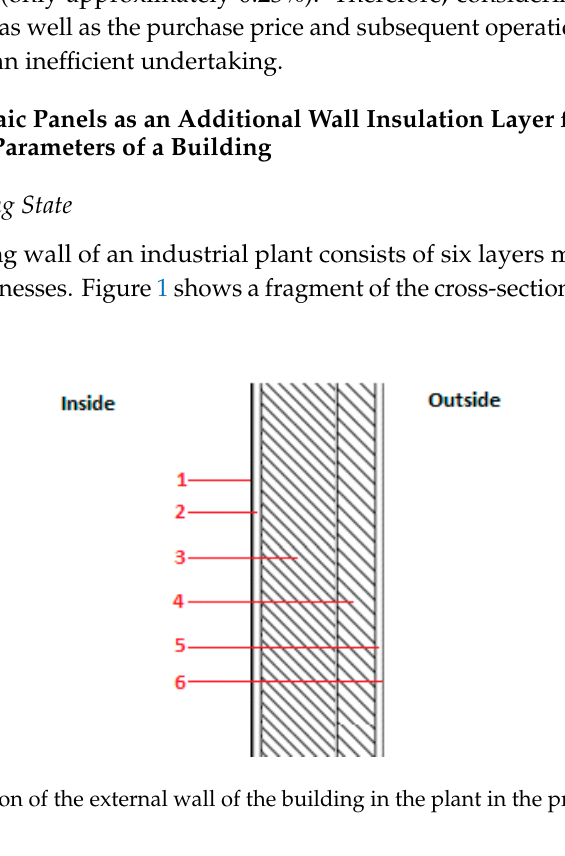
Table 2. Parameter values for subsequent partitions in the external wall of the building [67].